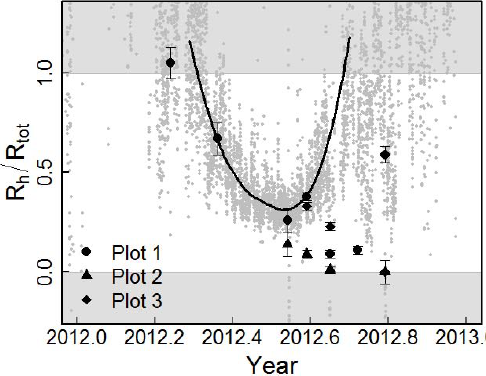
Fig. 6. Heterotrophic contributions to total soil respiration, esti- mated by two methods. Grey points show hourly R h / R tot estimated from the quotient of surface fluxes from the trenched and intact plots (all intact plots averaged). Solid black line shows mean quotient es- timated by loess fitting. Black points show 14 C partitioning esti- mates for each